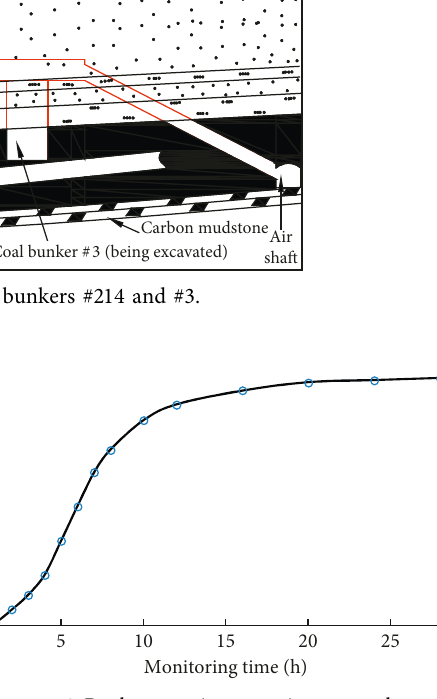
Figure 6: Rock expansion experiment